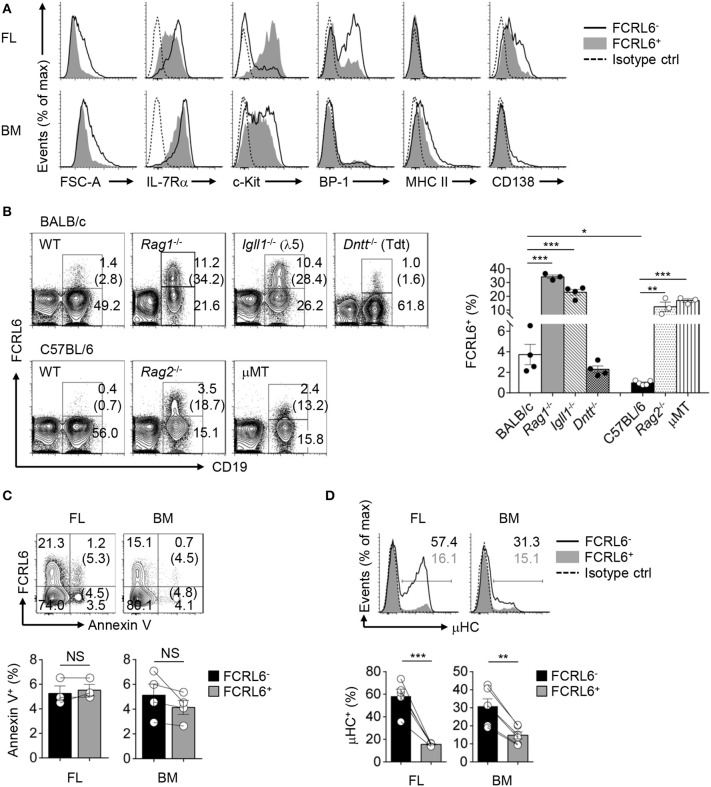
FCRL6+ pro B cells exhibit protracted development, expand in Igh defective mice, and generate little cytoplasmic IgM (μHC). (A) Flow cytometry analyzing FCRL6+ and FCRL6− pro B cells in E18 FL (above) and adult BM (below) to assess cell size by forward scatter (FSC) and co-expression of indicated surface markers. (B) Flow cytometry of total BM cells isolated from adult WT BALB/c and C57BL/6 mice or genetic mutants (n = 3–5 per strain) on related background strains stained for FCRL6 and CD19 as well as IgM to dump immature/mature B cells. Numbers adjacent to the gates indicate the percent of cells among total lymphocytes. The frequency of FCRL6+/CD19+ B cells is indicated in parentheses and summarized in the bar graph to the right. (C) Survival differences of FL and BM FCRL6+ and FCRL6− pro B cells evaluated by Annexin V staining and flow cytometry. The frequency of FCRL6+ or FCRL6− Annexin V+ pro B cells is indicated in parentheses. (D) Representative intracellular IgM staining of FL and BM FCRL6− and FCRL6+ pro B cells. Each symbol represents an individual mouse. Small horizontal lines (B–D) indicate s.e.m. NS, not significant (P > 0.05); *P < 0.05; **P < 0.01; ***P < 0.001 as determined by unpaired (B) or paired (C,D) Student's t-test. Data are representative of at least two experiments (A–C), or more than 10 independent experiments (D).